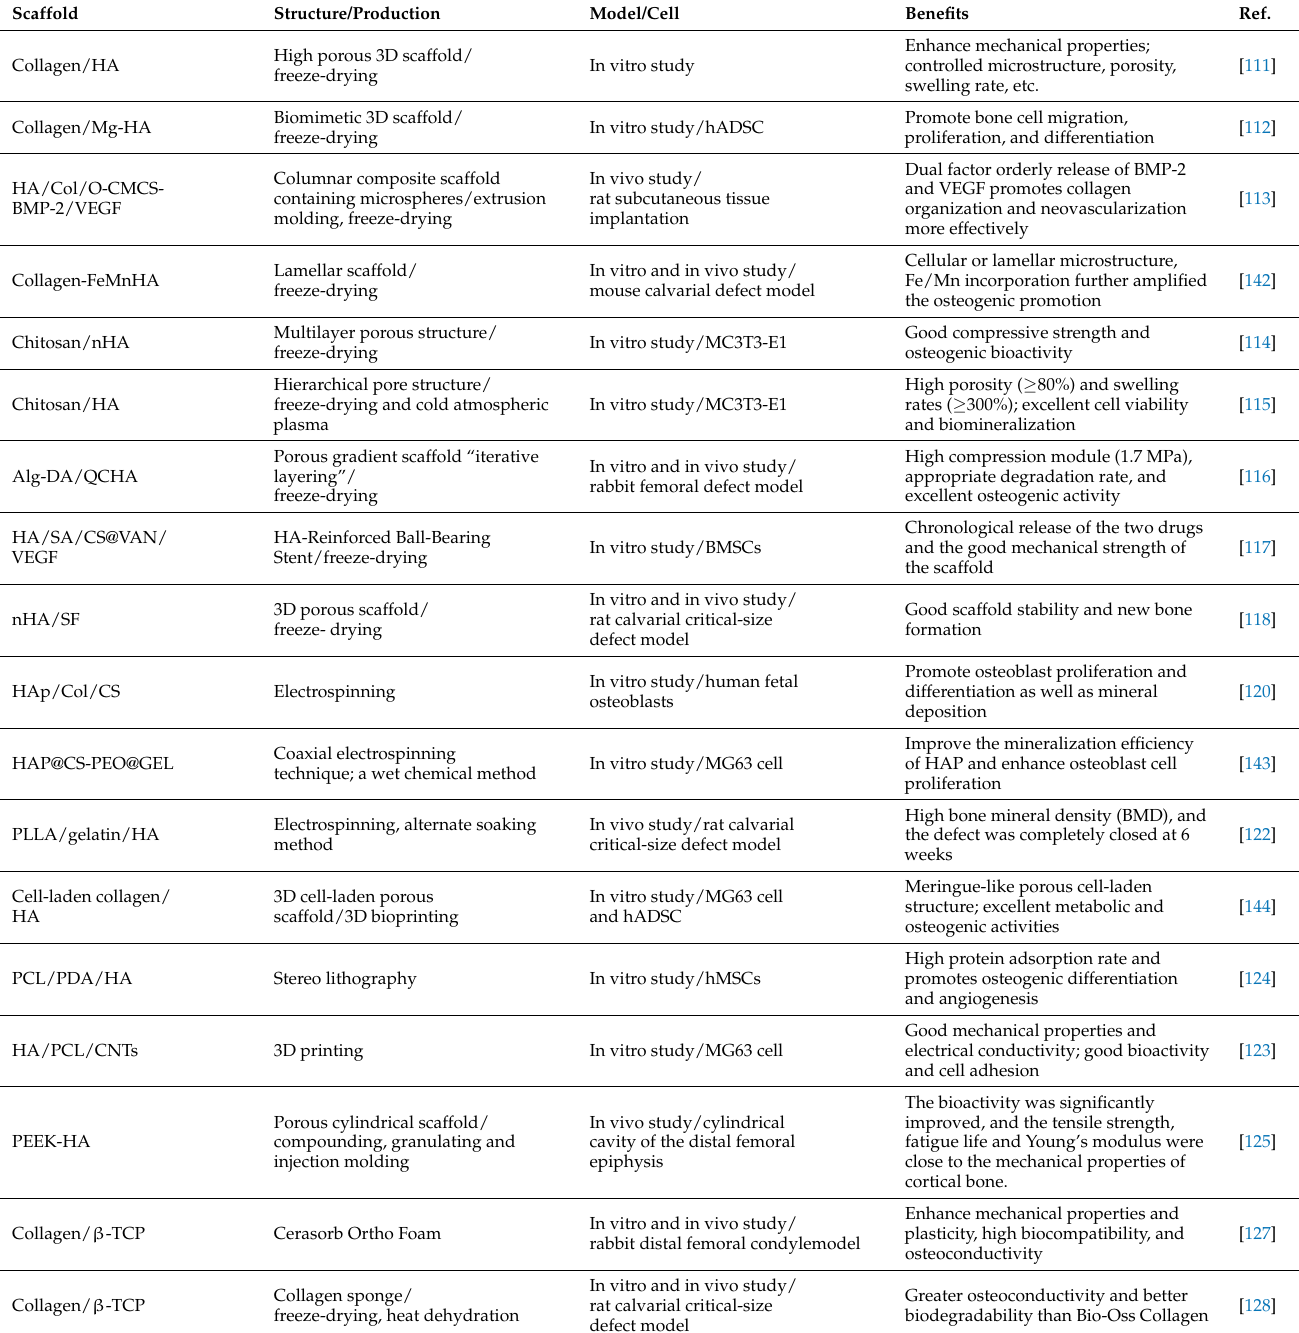
Table 1. Summary of recent studies on polymer-based bioceramic composite scaffolds used in bone tissue